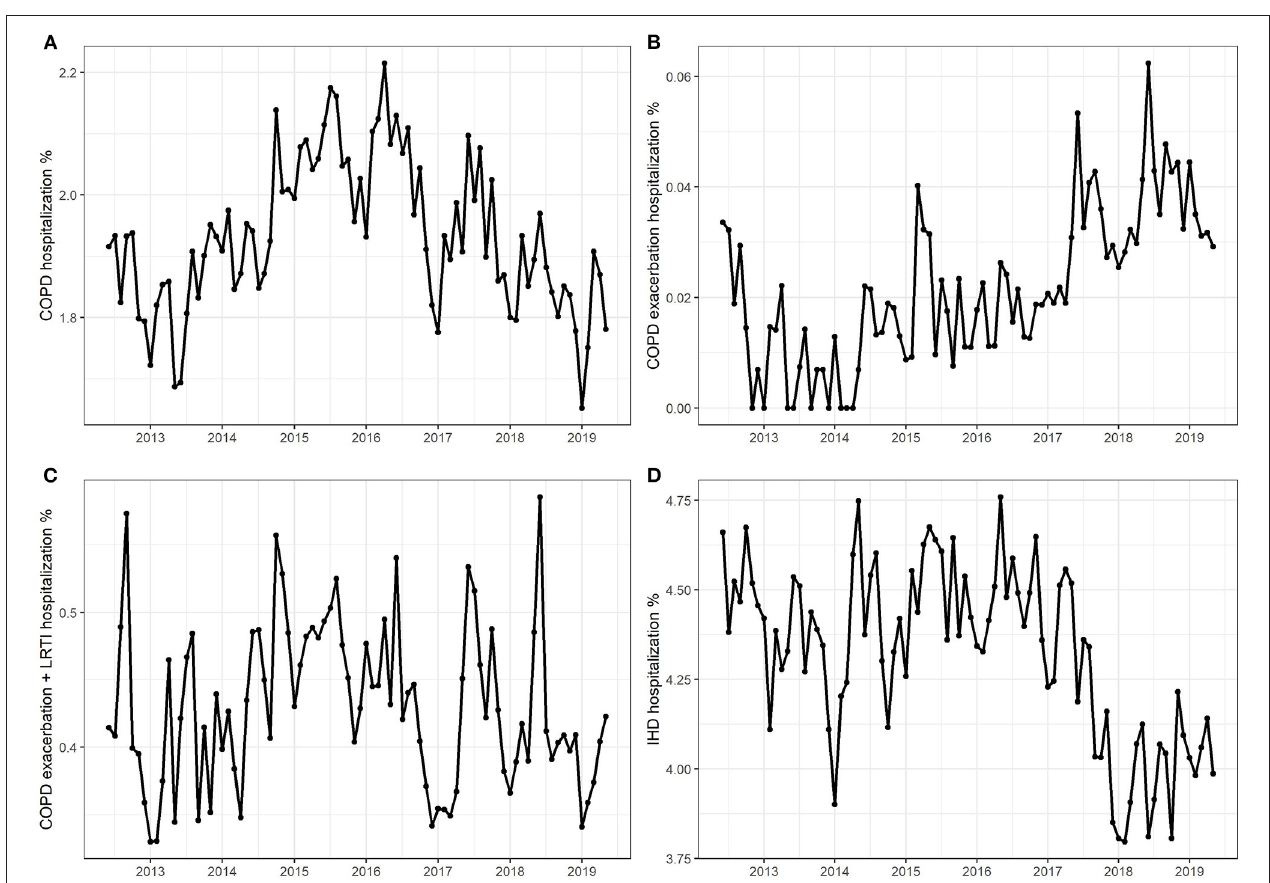
FIGURE 1 | Monthly hospitalization numbers due to (A) chronic obstructive pulmonary disease (COPD), (B) COPD exacerbations, (C) COPD exacerbations + lower respiratory tract infection, and (D) ischemic heart disease.